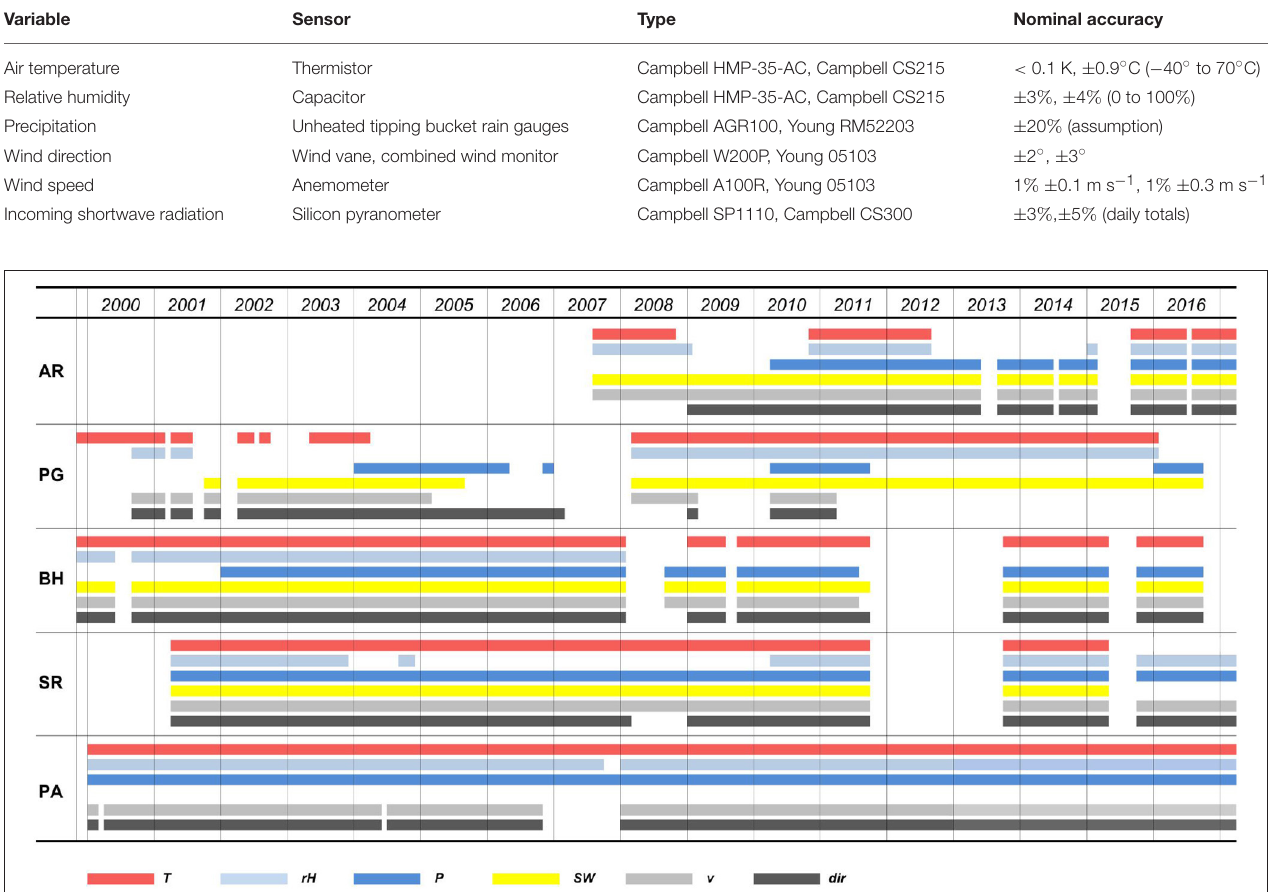
TABLE 2 | Instrumentation at AWS Paso Galería, AWS Puerto Bahamondes, AWS Arévalo, and AWS Skyring as used in this study.